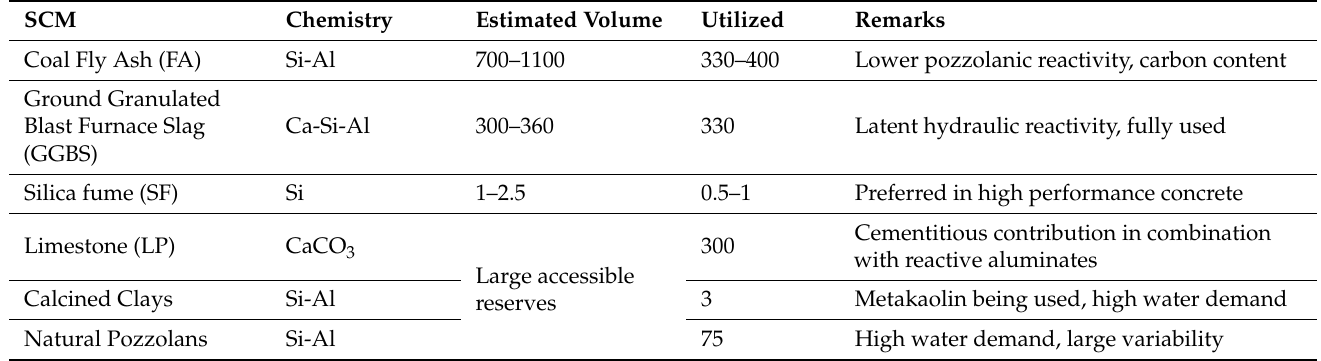
Table 4. Estimated yield and utilization volume (million tonnes per year) of standardized SCMs